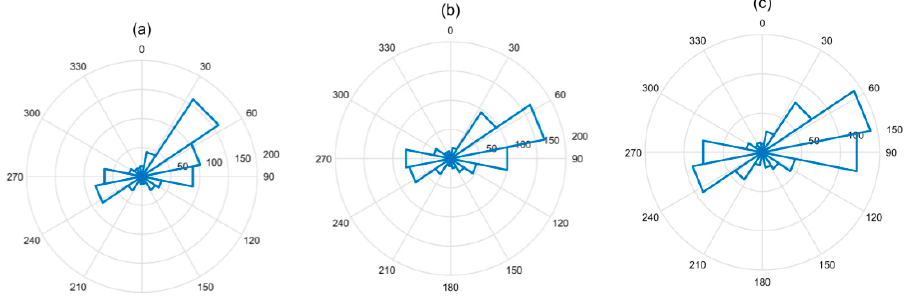
Figure 8. Distributions of wind roses at heights of ( a ) 10 m, ( b ) 30 m, ( c ) 60 m of the anemometer tower in March 2014.